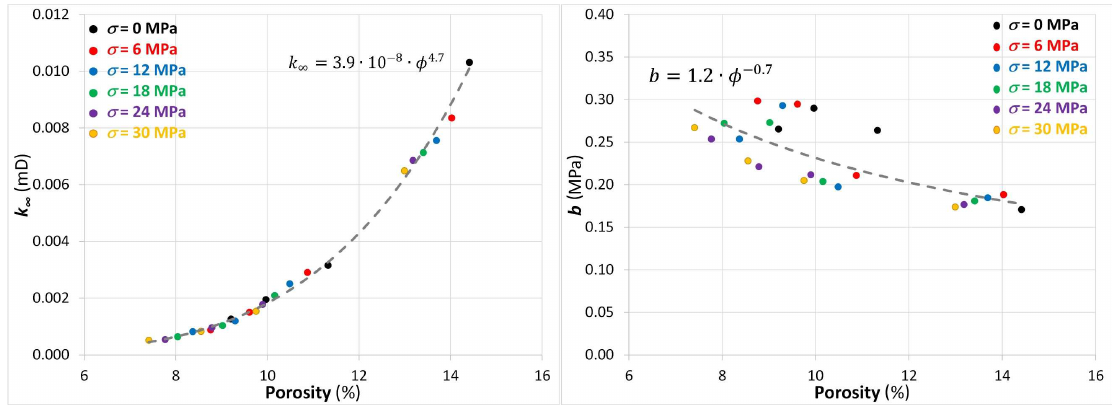
Figure 8. The relationships between the values of the Klinkenberg permeability coefficient k ∞ , and the slippage factor b , as a function of the porosity, obtained from the tests on the coal samples M1–M4 using methane, where: σ —are the stress values; φ —is the porosity.